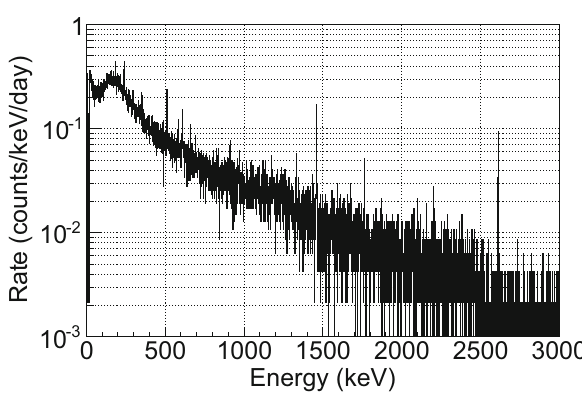
Fig. 8 Total HPGe spectrum for 2017–2018 (670 days live time)